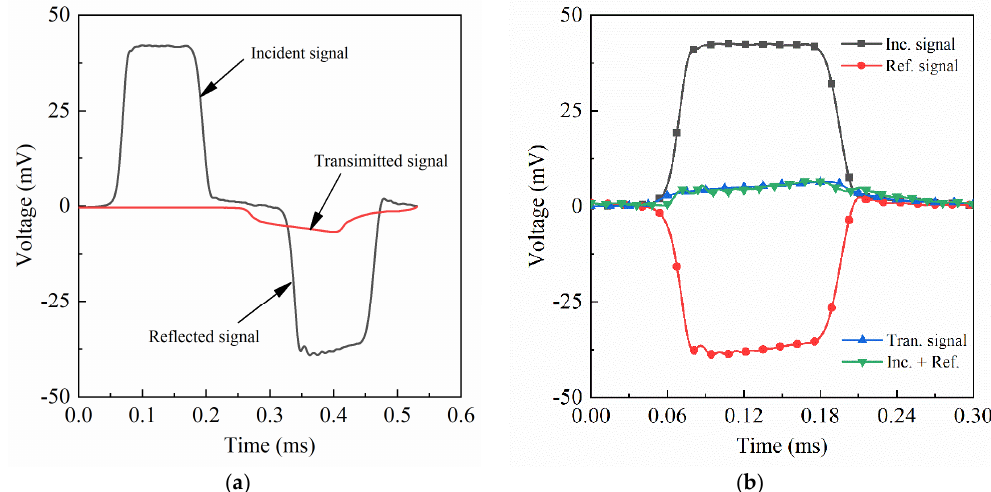
Figure 5. Stress waves and the stress equilibrium result of a typical test. ( a ) Signals of the stress waves in a test; ( b ) results of the stress equilibrium.